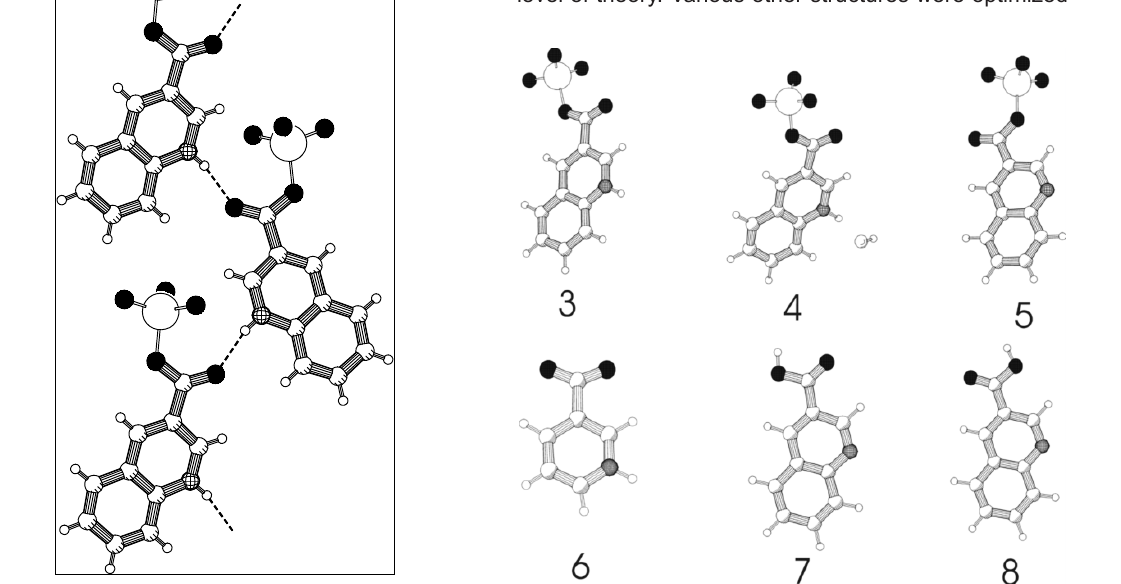
Figure 2. PLUTON view of the intermolecular hydrogen bonding system in the solid state of (quinolinium-3-carboxylato-O) trioxidochromium(VI).